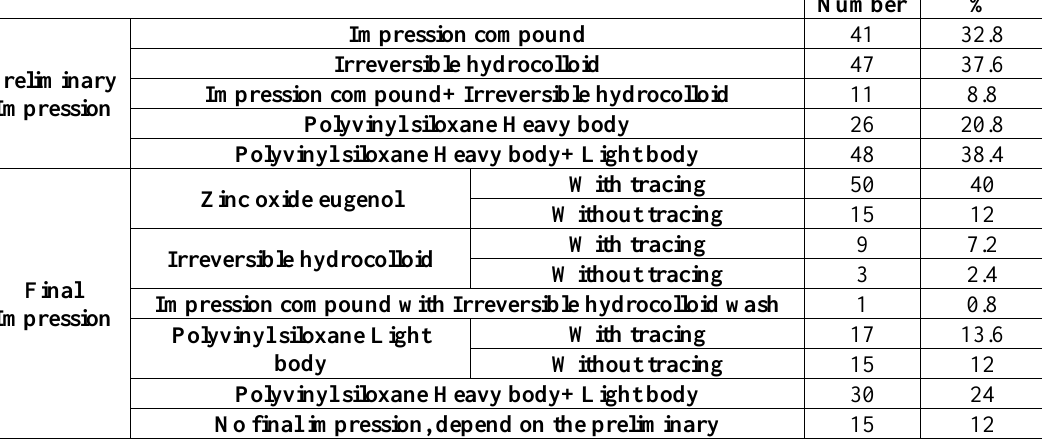
Table 4: Types of Preliminary and Final impression materials used for complete denture